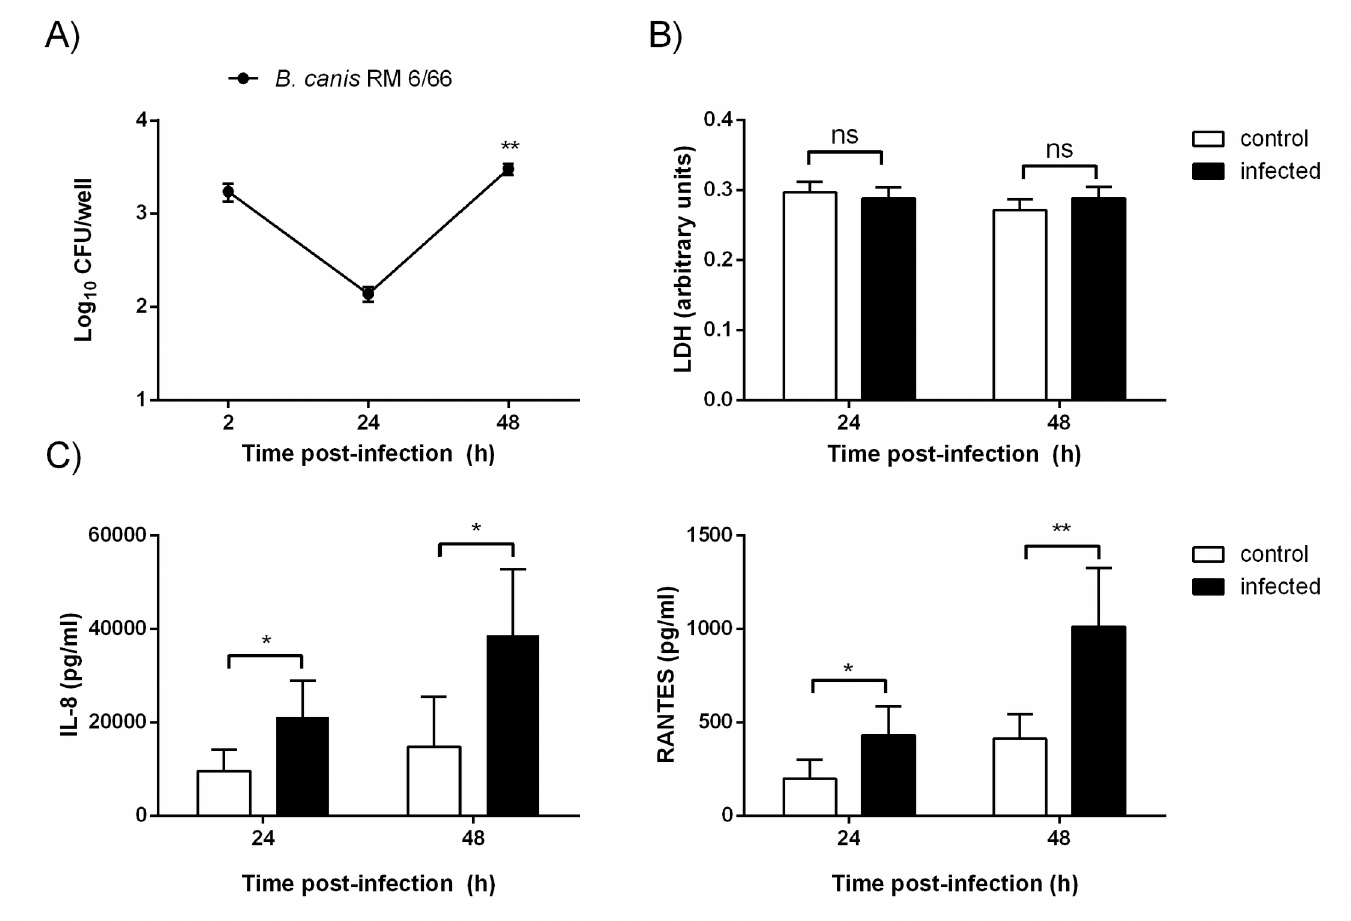
Fig 2. B . canis infects and replicates in canine trophoblasts without inducing cytotoxicity, but inducing proinflammatory chemokines. Trophoblasts isolatedfrom 6 term placentas(1x10 5 cells) were infected with B . canis at MOI 250 for up to 48 h. (A) After additionof antibiotics to kill extracellular bacteria, cells were lysed at 2, 24 and 48h to enumerateCFU counts. (B) Culturesupernatants from trophoblastsuninfectedand infected with B . canis were harvestedat 24 and 48 h p.i. to measurelactate dehydrogenase (LDH) activity. Values in A and B are means ± SD of duplicatemeasurements from three independentexperiments. Asterisks indicate significantdifferences between24 and 48h p.i ( ** p < 0.01,Mann-Whitney test). (C) Culture supernatants were harvestedat 24 and 48 h p.i. to measureIL-8 and RANTES (CCL5) secretion. Culturesupernatants from uninfectedtrophoblasts